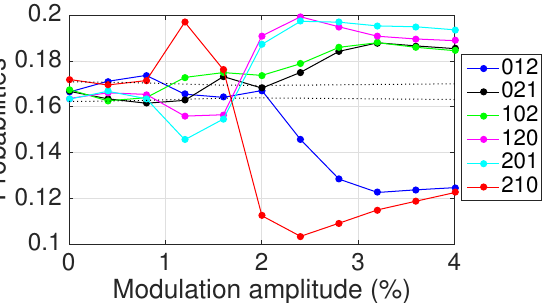
Figure 1. Word probabilities of a photonic neuron as a function of the modulation amplitude. Time delay is 4.7 ns. Frequency of the modulation is 17 MHz. A constant DC current of 39 mA drives the laser, with a modulation of the pump current on top between 0 and 4% of the DC current. Dotted lines indicate the null hypothesis region of dynamics compatible with a stochastic process (all words equally